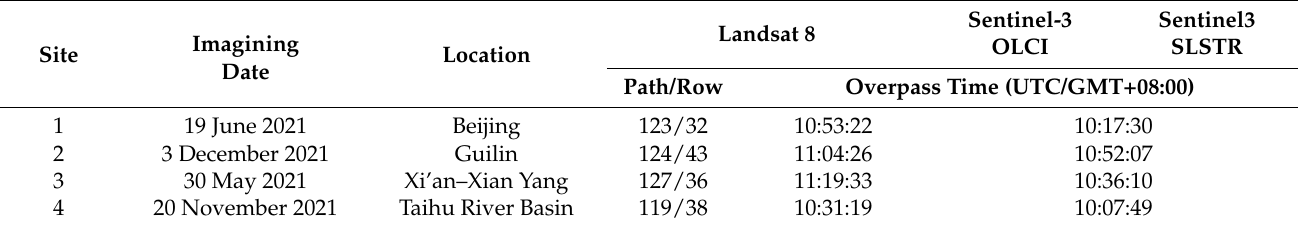
Table 1. List of study sites and Landsat 8 and Sentinel-3 images used in this study.